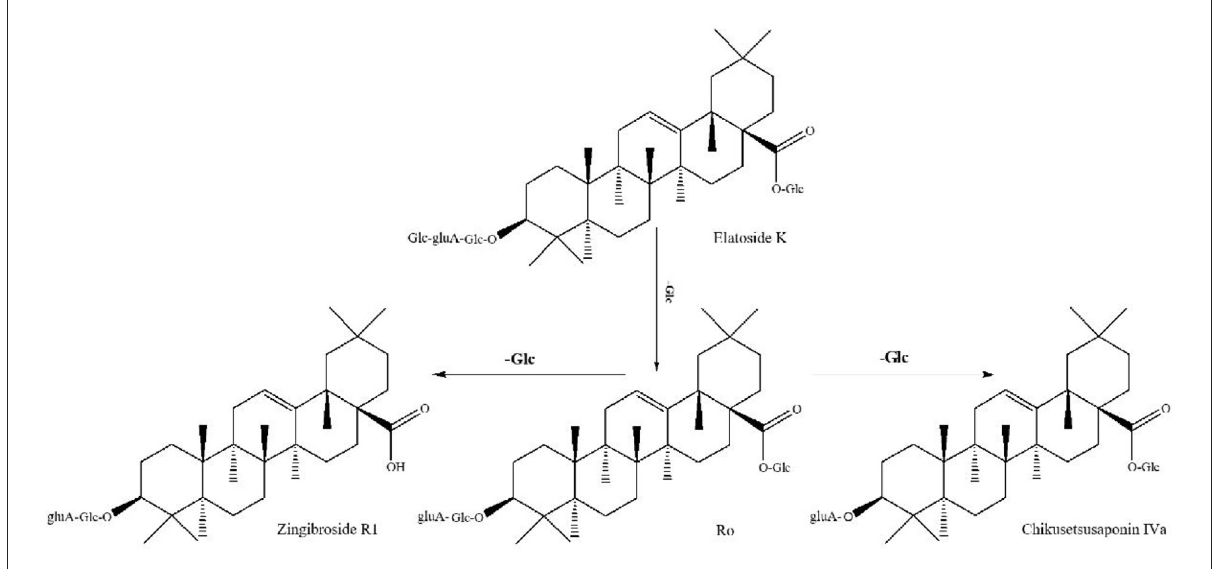
FIGURE7 Possible transformation pathways of OLE-type ginsenosides under the action of